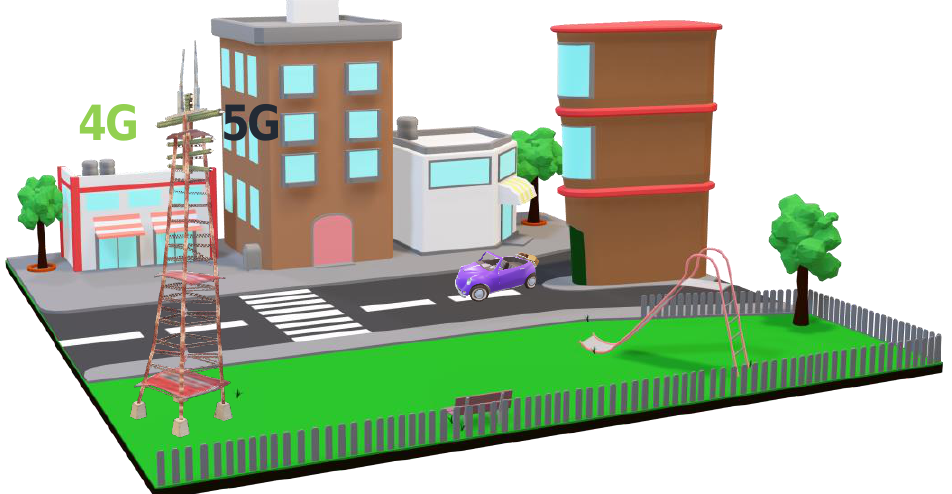
Figure 1. An illustration of the non-standalone implementation of 5G network infrastructure where 5G and 4G base stations are located at the same tower.